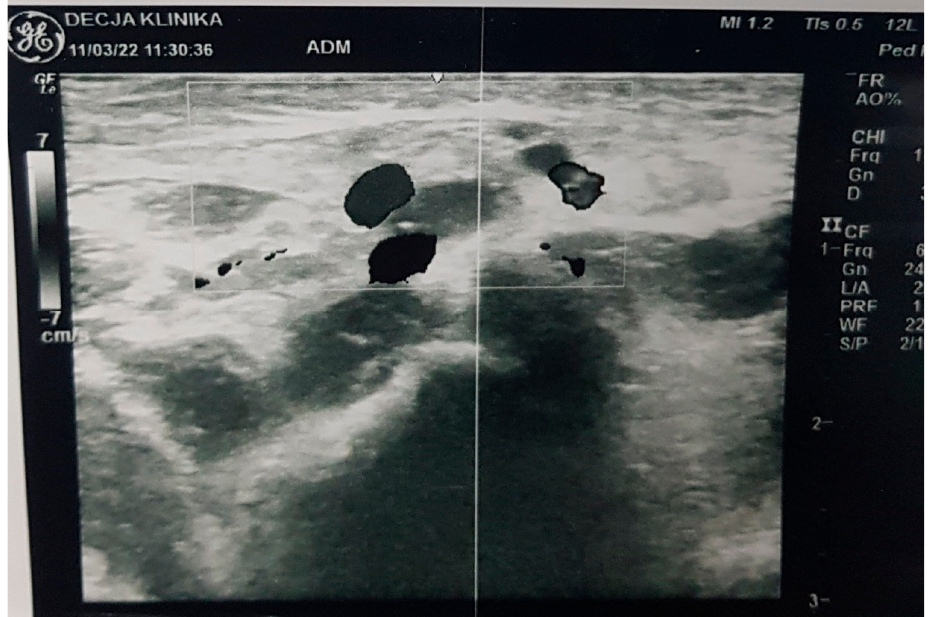
Figure 1. Ultrasound finding of blood vessels: The thrombosis of the femoral vein and iliac vein, on the right side, in newborn 1. The right femoral vein, right side, has a reduced diameter, long with 9 mm, lumen up to 50%, with a pre-obstructive dilatation of the blood vessel of about 5 mm. The right iliac external vein is from the level v. femoral along about 20 mm long filled with heteroechoic contents, more hyperechoic contents, corresponding to the thrombosis. A. femoris and a. iliaca external are preserved flow.